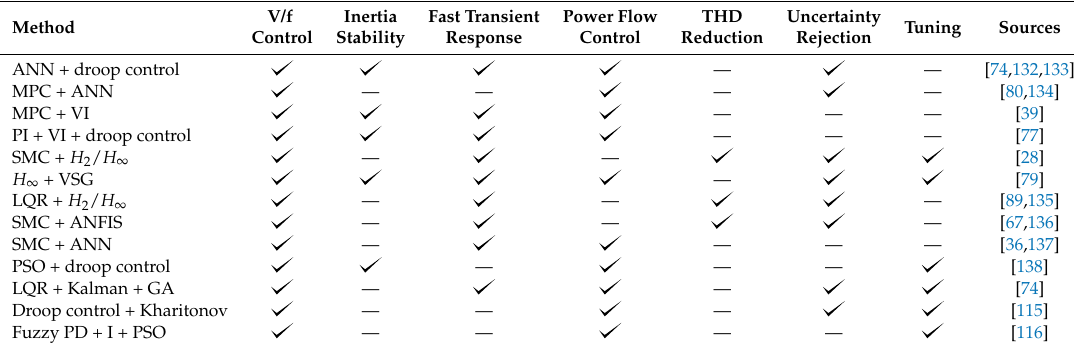
Table 5. Particular objectives on inverter-based MG